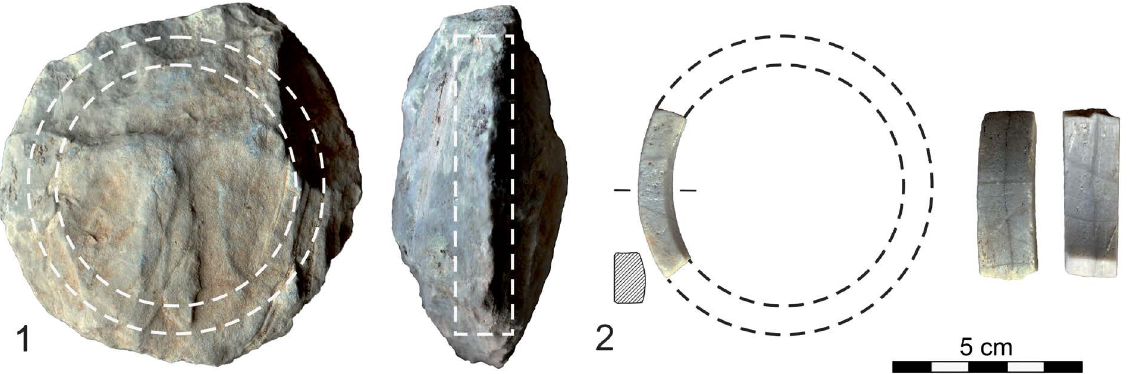
Figure 4. Schematic explanation of the use of preforms to make bracelets. 1. Preform nearly finished and 2. Example of finished stone bracelet (settlement Cortijo Higuera Alta).